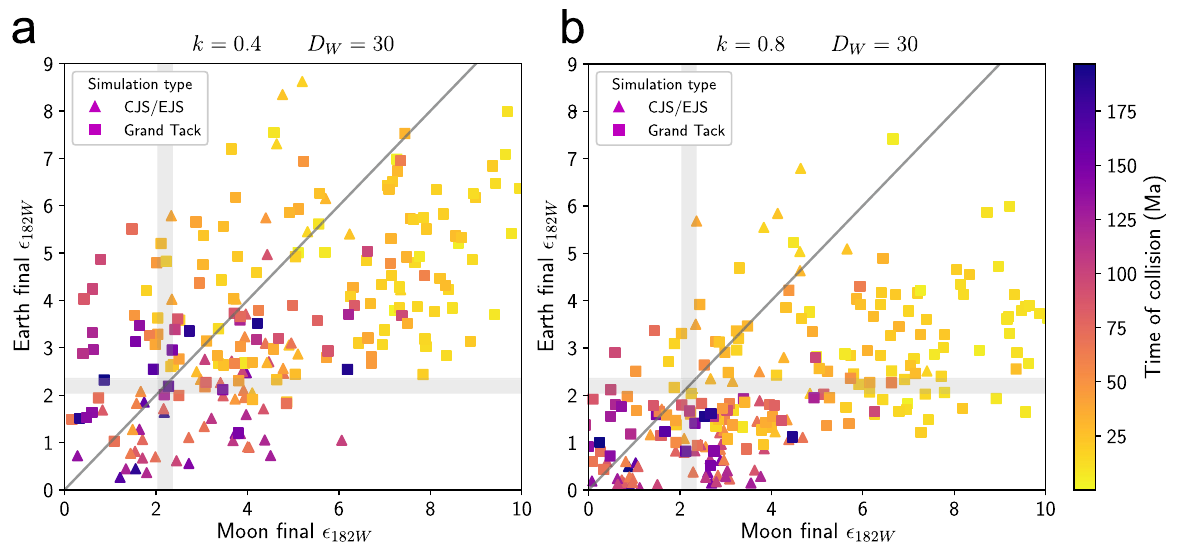
Fig. 2 Final ε 182W of Earth – Moon pairs. The 1:1 line represents an identical 182 W anomaly in the Earth and Moon as observed, a low-probability event. Gray shaded boxes: actual pre-late veneer ε 182W in the Earth and Moon 5 . Symbol shape indicates accretion scenario; symbol color indicates the time of the Moon-forming collision (expressed as time since Solar System formation). Results are shown for a lunar W metal – silicate partition coef fi cient D W = 30 and whole mantle equilibration. In a , the fraction of equilibrating metal was k = 0.4, which provides the best match to Earth ’ s ε 182W on average in Circular Jupiter and Saturn (CJS) and Eccentric Jupiter and Saturn (EJS) scenarios; 19,21 in b , it was k = 0.8, which provides the best match to Earth ’ s ε 182W on average in the Grand Tack scenario 27 . Lunar ε 182W was calculated assuming that the Moon formed entirely from Theia materials, with no terrestrial component. While CJS/EJS Earth analogs in a and Grand Tack Earth analogs in b match the observed ε 182W on average, 75 and 85% of Moon analogs, respectively, have anomalies that are too high.